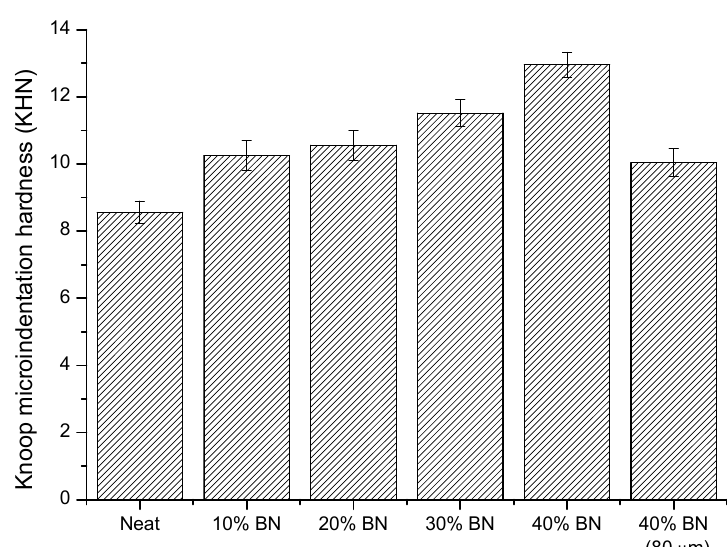
Figure 6. Dependence of the microindentation hardness of ECC/thiol thermosets with different weight percentages of BN.